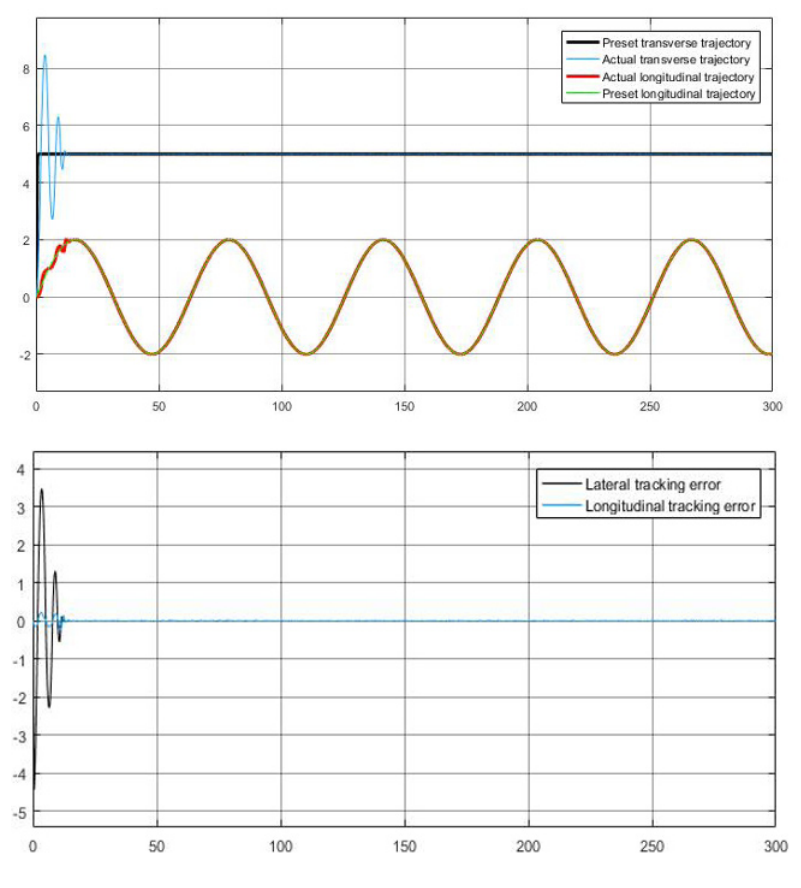
Fig. 7. Second-order system for UAV trajectory